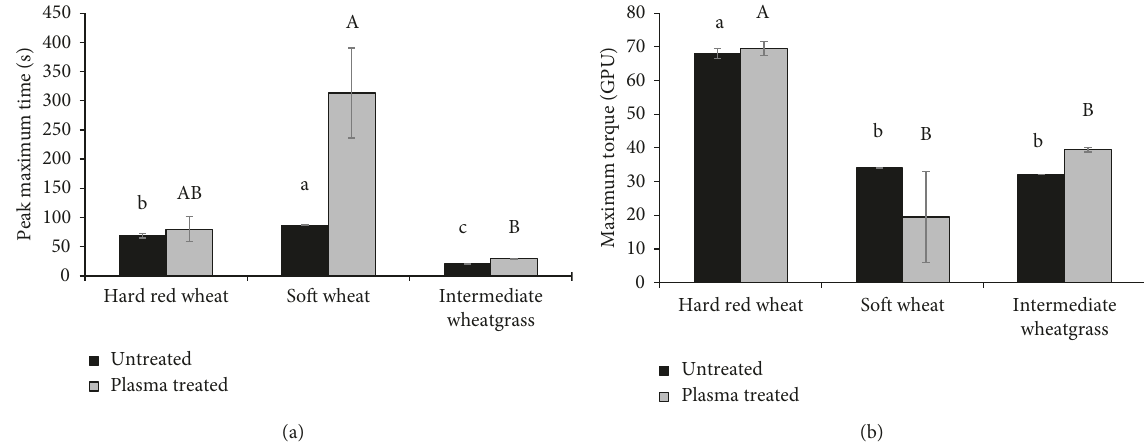
Figure 4: Peak maximum time (PMT) and maximum torque (MT) of hard red wheat, soft wheat, and intermediate wheatgrass flour before and after plasma